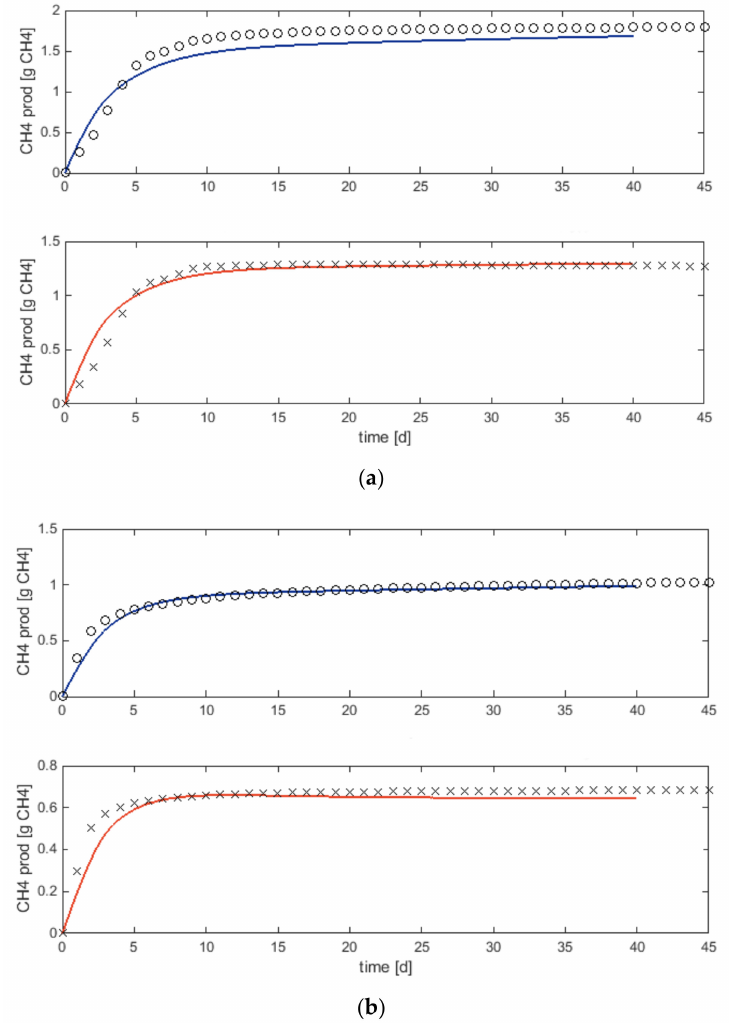
Figure 2. ( a ) Cumulative methane production from the biomethane potential tests of the organic fraction of municipal solid waste (OFMSW); ( b ) Cumulative methane production from mixed sludge. For each substrate, the total biomethane production (top) is displayed, as well as the net production corrected for inoculum (bottom). Markers represent data and lines show model results